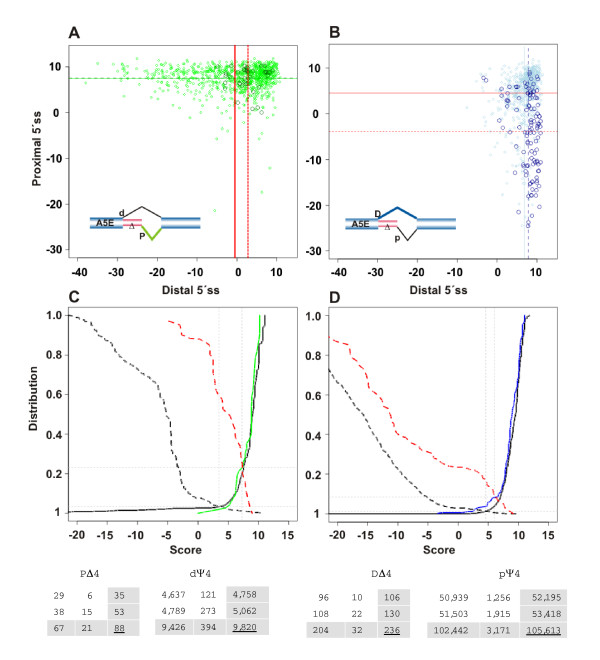
Scatter plots of 5'ss scores of competitive and tandem donors (cf. notation of Figure 4). The upper panel shows the individual and mean scores (the latter is marked by solid/dashed lines); the lower panel compares on the left-hand side the cumulative score distribution of PΔ4 and dΔ4 splice sites with constitutive 5'ss and dΨ4 (pseudo distal 5'ss, in black), and on the right-hand side pΔ4 and DΔ4 splice variants with pΨ4 and 5'ss (pseudo proximal 5'ss, in black). The threshold at which the curves intersect (S*) marks the accuracy (A) at which sets can be distinguished with equal classification errors on major and minor splice variants. A(S*) ≈ 78% for PΔ4 versus dΔ4 (PΔ4/dΔ4) and A(S*) ≈ 92% for pΔ4/DΔ4, and A(S*) ≈ 95% for dΨ4/5'ss and A(S*) ≈ 99% for 5'ss/pΨ4. In the bottom, tables show the number of exons of each type above and below S*; ordered table entries are: TP, FP, TN, and FN (on white background).